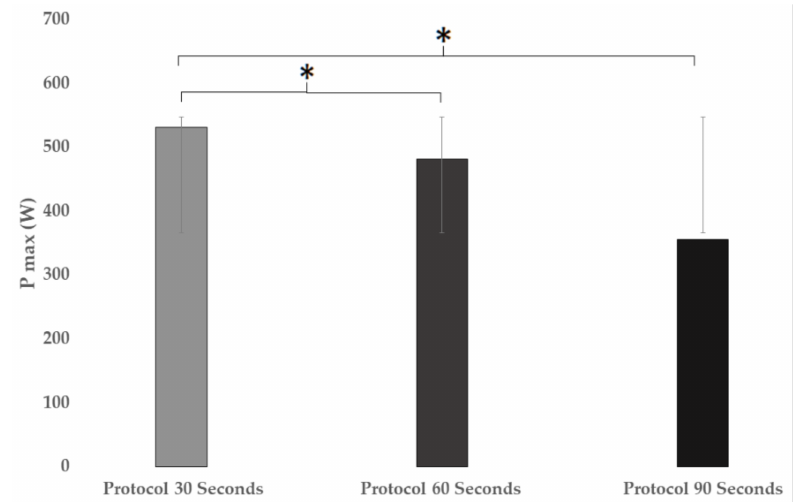
Figure 2. Comparison of maximum power developed in different High-Intensity Interval Training (HIIT) protocols. * means significant difference.